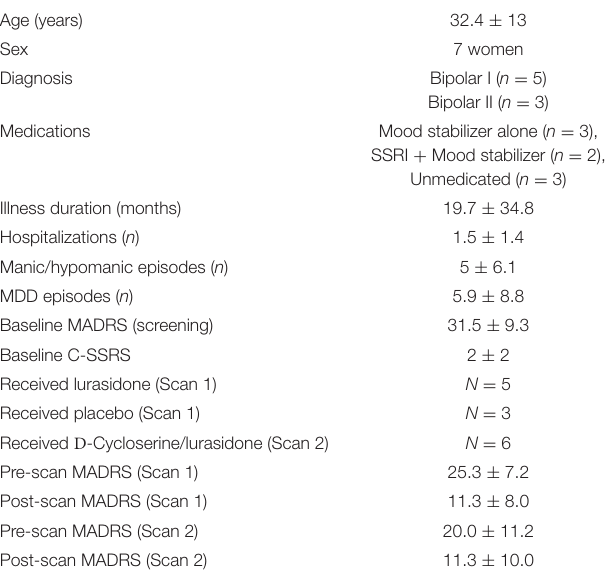
TABLE 1 | Baseline demographics, psychopathology and subject